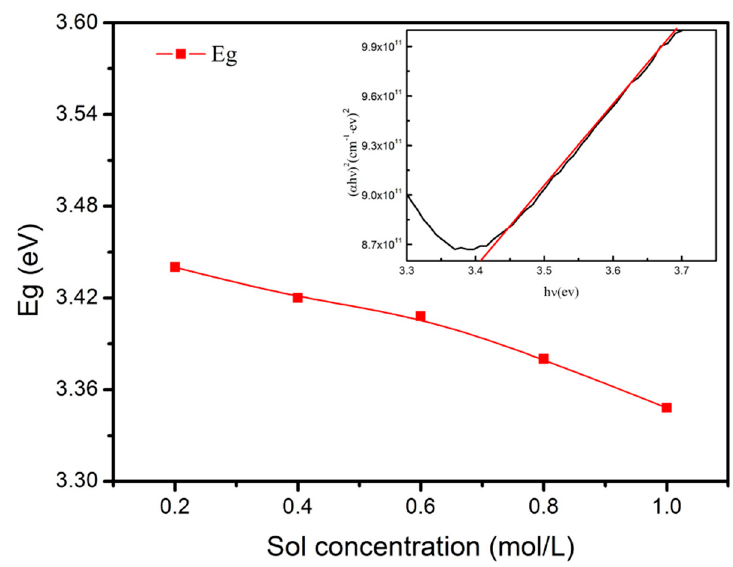
Figure 9. Variation of band gaps of ZnO films according to the sol concentration. Inset: typical plot of ( α h υ ) 2 versus photon energy ( h υ ) of the 0.6 M ZnO films.